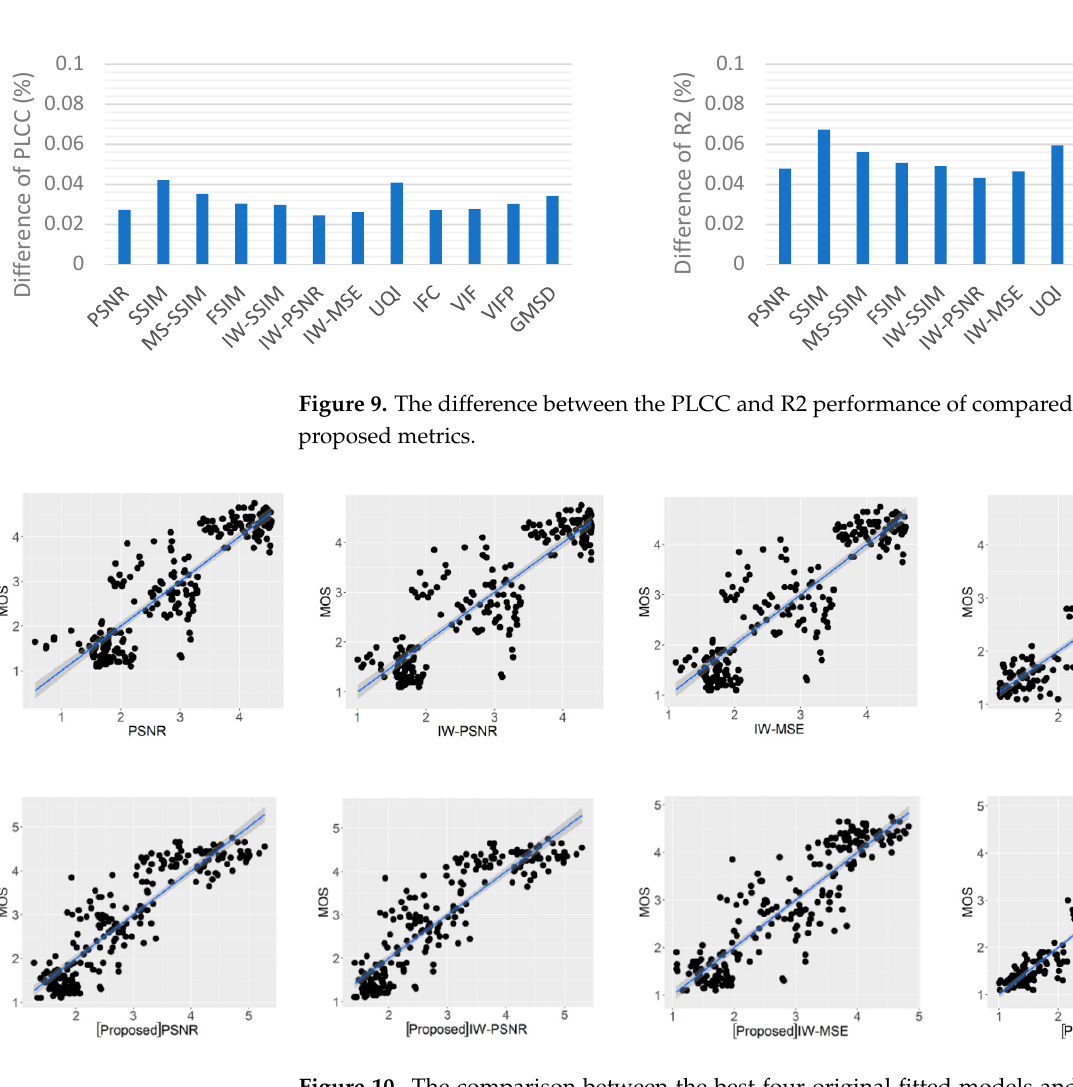
Figure 10. The comparison between the best four original fitted models and the proposed fitted models on the LF dataset. The black dots in the scatter plots represent a paired measurement of two variables (i.e., Objective quality metric and MOS), while the blue lines are the fitted linear function on the LF dataset of each objective quality metric. The top row presents the original metrics, and the bottom row presents the proposed model applying to the following objective